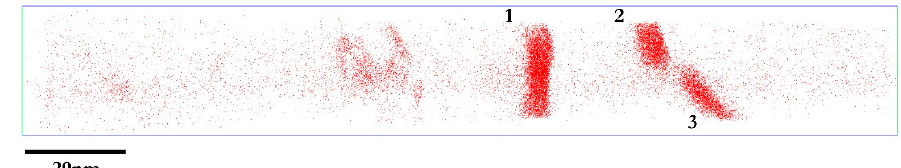
Figure 15. Carbon distribution map in martensite with three carbides (QT200/200s). The total volume analyzed was 30 nm × 30 nm × 140 nm containing 20 × 10 5 ions. Each red dot is one individual carbon atom detected.